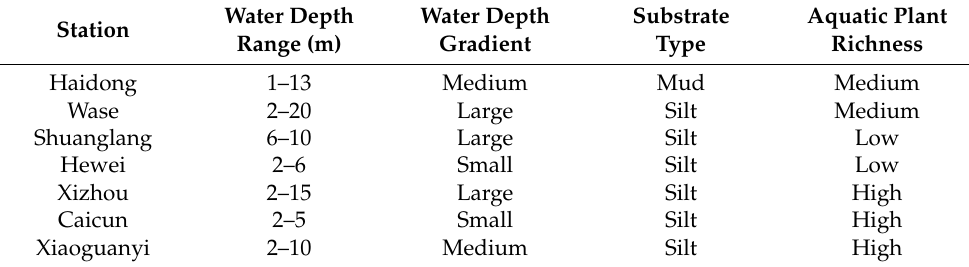
Table 1. Environmental variables for each of the sampling sites in Lake Erhai. Water Depth Station Range